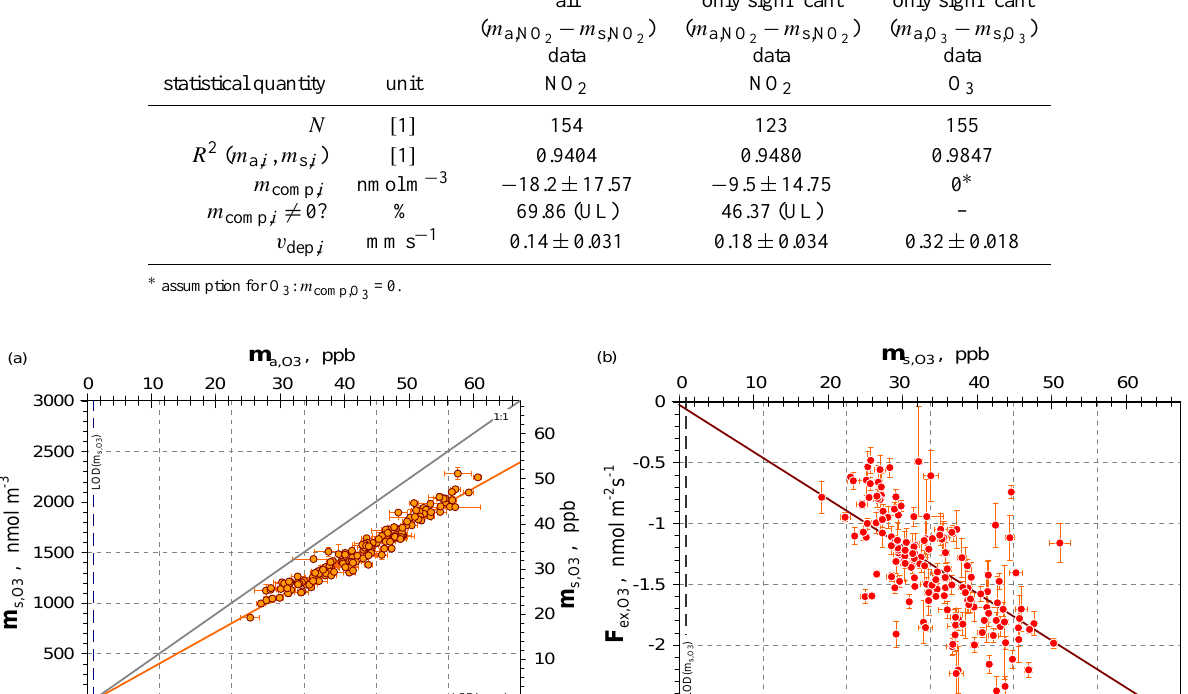
Figure 14. Field measurements: (a) O 3 concentration measured at the outlet of the dynamic plant chamber ( m s,O3 ) vs. O 3 concentration measured at the inlet of the dynamic plant chamber ( m a,O3 ). Orange circles identify data pairs for significance of m O3 = ( m a,O3 m s,O3 ). Orange line is calculated according to bi-variate weighted linear least-squares fitting regression analysis (see Sect. 3.4.6). (b) O 3 exchange flux density ( F ex,O3 ) vs. O 3 concentration measured at the outlet of the dynamic plant chamber ( m s,O3 ). F ex,O3 data were calculated according Eq. (1.3), their standard errors according to Eq. (14). Dark red line is calculated according to Eq. (6.3).